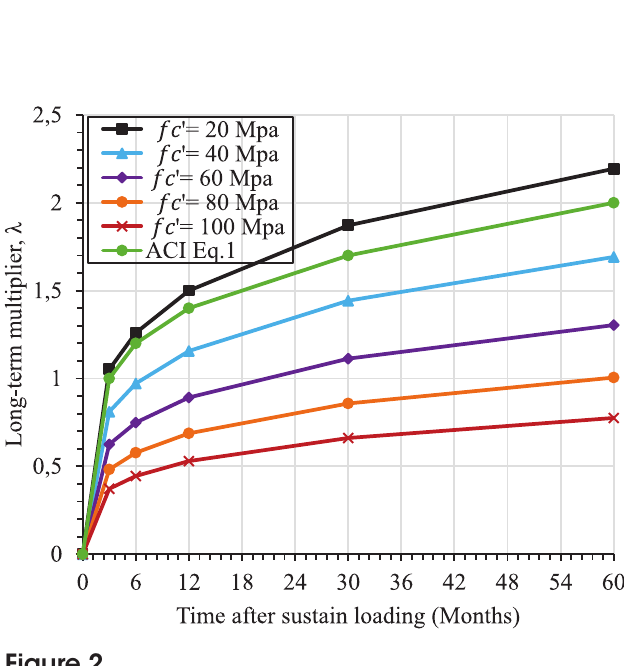
Figure 2 Effects of compressive strength (f the long-term deflection multiplier ( λ